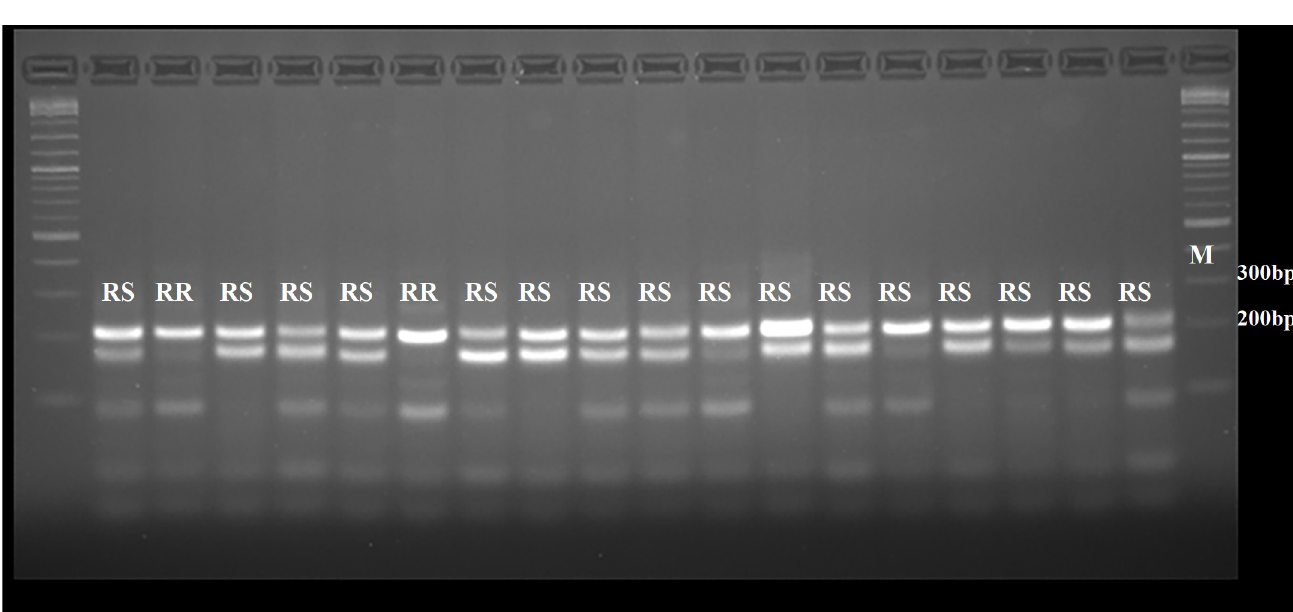
Fig 3. Digestion patterns of the restriction enzyme, Sau 96I used for the dCAPS markers for detecting mutations at codon 106 in the EPSPS gene in 18 individuals from a glyphosate-resistant Blenheim population. The presence of the 216 bp dCAPS amplicon indicated a non-cleaved resistant allele of the EPSPS gene, whereas the ~180 bp cleaved amplicon showed presence of the glyphosate-sensitive allele. RS and RR represent digested samples for glyphosate-resistant individuals that were heterozygous and homozygous, for SNP mutations conferring resistance at codon 106 in the EPSPS gene. M denotes the DNA size standard lanes showing the 200 and 300 bp fragments of the 1 kb Plus size marker ladder (NEB, UK). The samples were resolved and visualized by electrophoresis in an agarose lithium borate buffer (2% w v -1 ) gel containing 0.5 μ g ml -1 ethidium bromide.